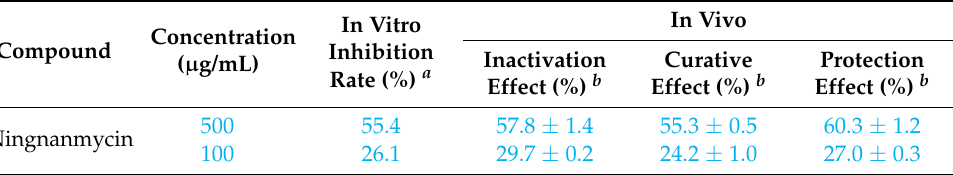
Table 1. In vitro and in vivo antiviral activities of ningnanmycin, ribavirin, matrine, and compounds 1 – 21 against TMV.